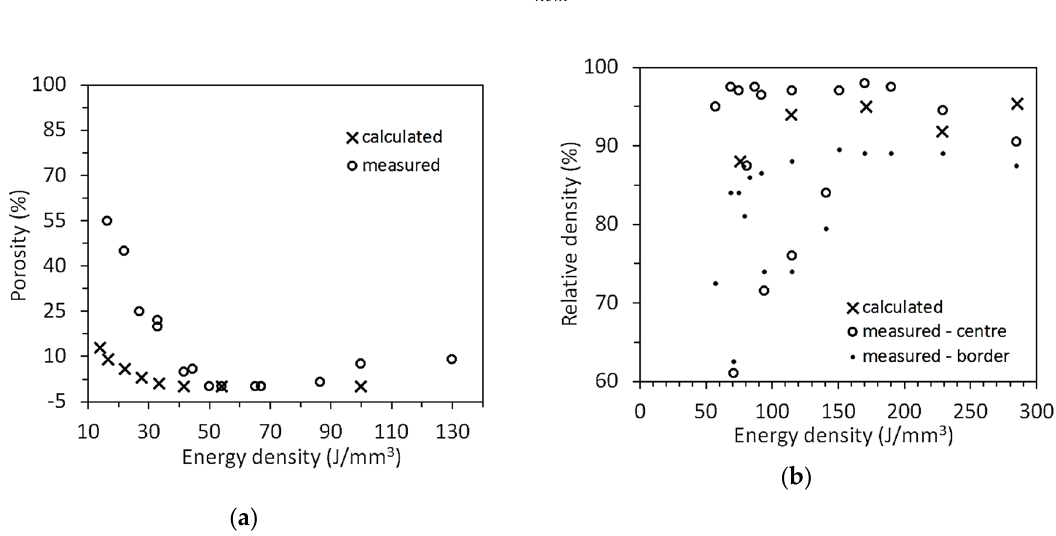
Figure 9. Comparison of measured and calculated values of: ( a ) porosity (Ti6Al4V, diagram taken from [30]); ( b ) relative density (pure copper, diagram taken from [31]). from [30]); ( b ) relative density (pure copper, diagram taken from